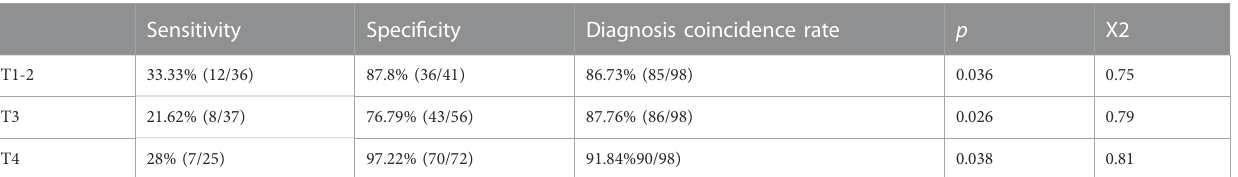
TABLE 5 CT staging ’ s sensitivity, speci fi city, and rate of diagnostic concordance.